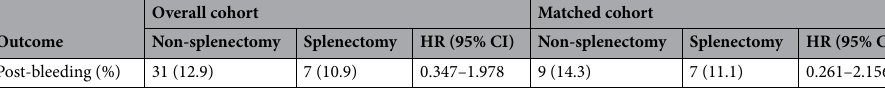
Table 2. Probability of variceal bleeding after TIPS.